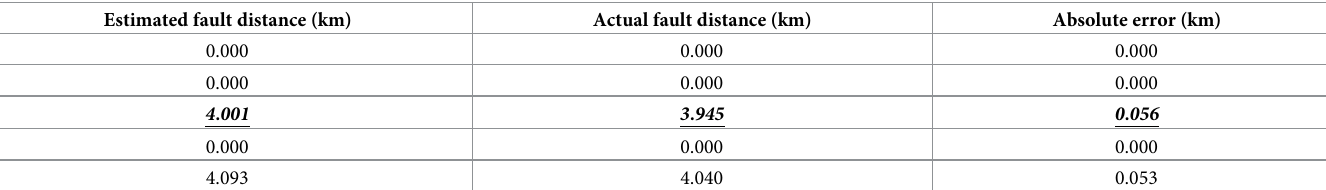
Table 6. Corrected fault distance estimation (AGF).